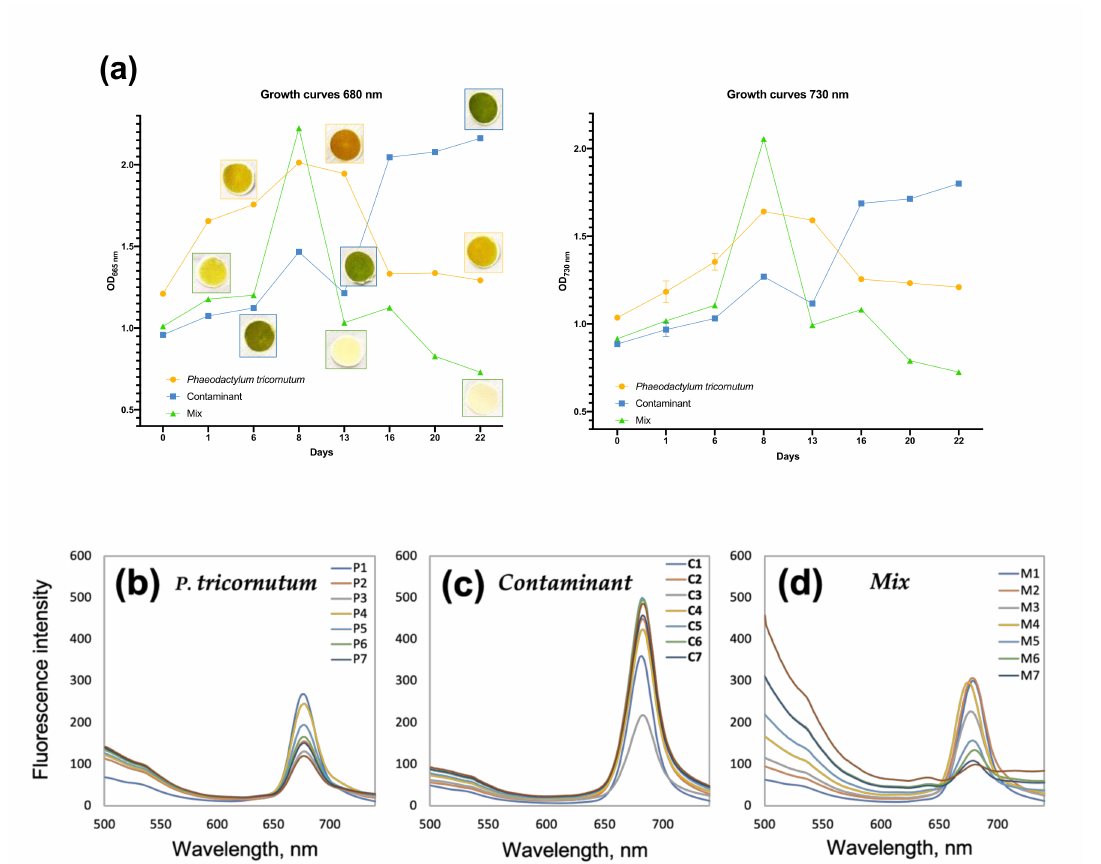
Figure 2. ( a ) Temporal trends of OD values at 680 and 730 nm, paper filters with filtrated cultured biomass are inserted in the 680 nm graph. ( b – d ) Fluorescence spectra, upon excitation at λ ex = 470 nm, of ( b ) P. tricornutum , ( c ) Contaminant and ( d ) Mix cultures over 22 day